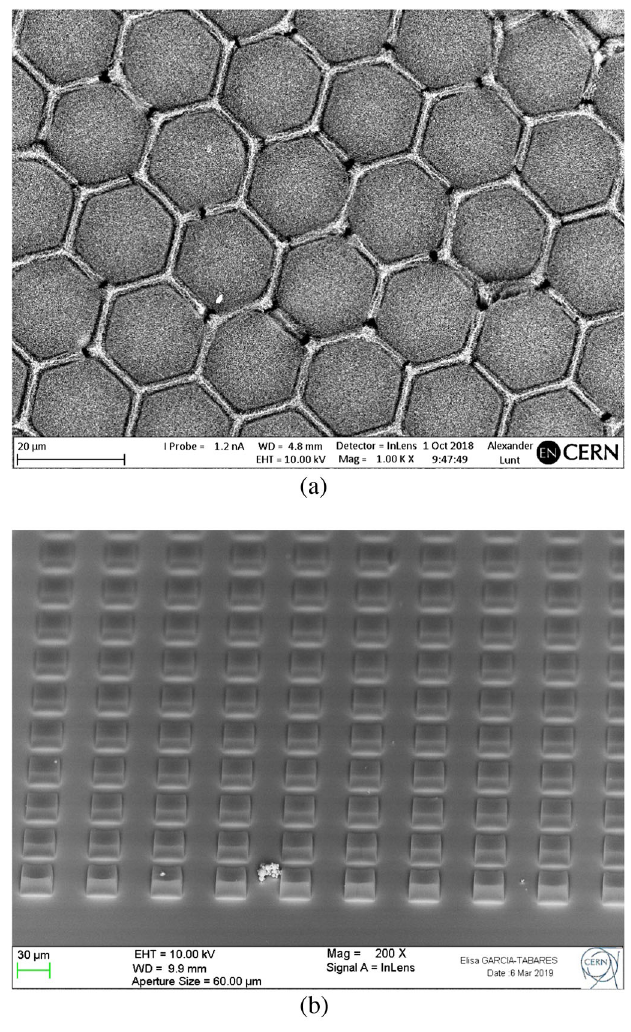
FIG. 3. SEM images of the honeycomb-like array CNT1 (a) and squared-islands array CNT2